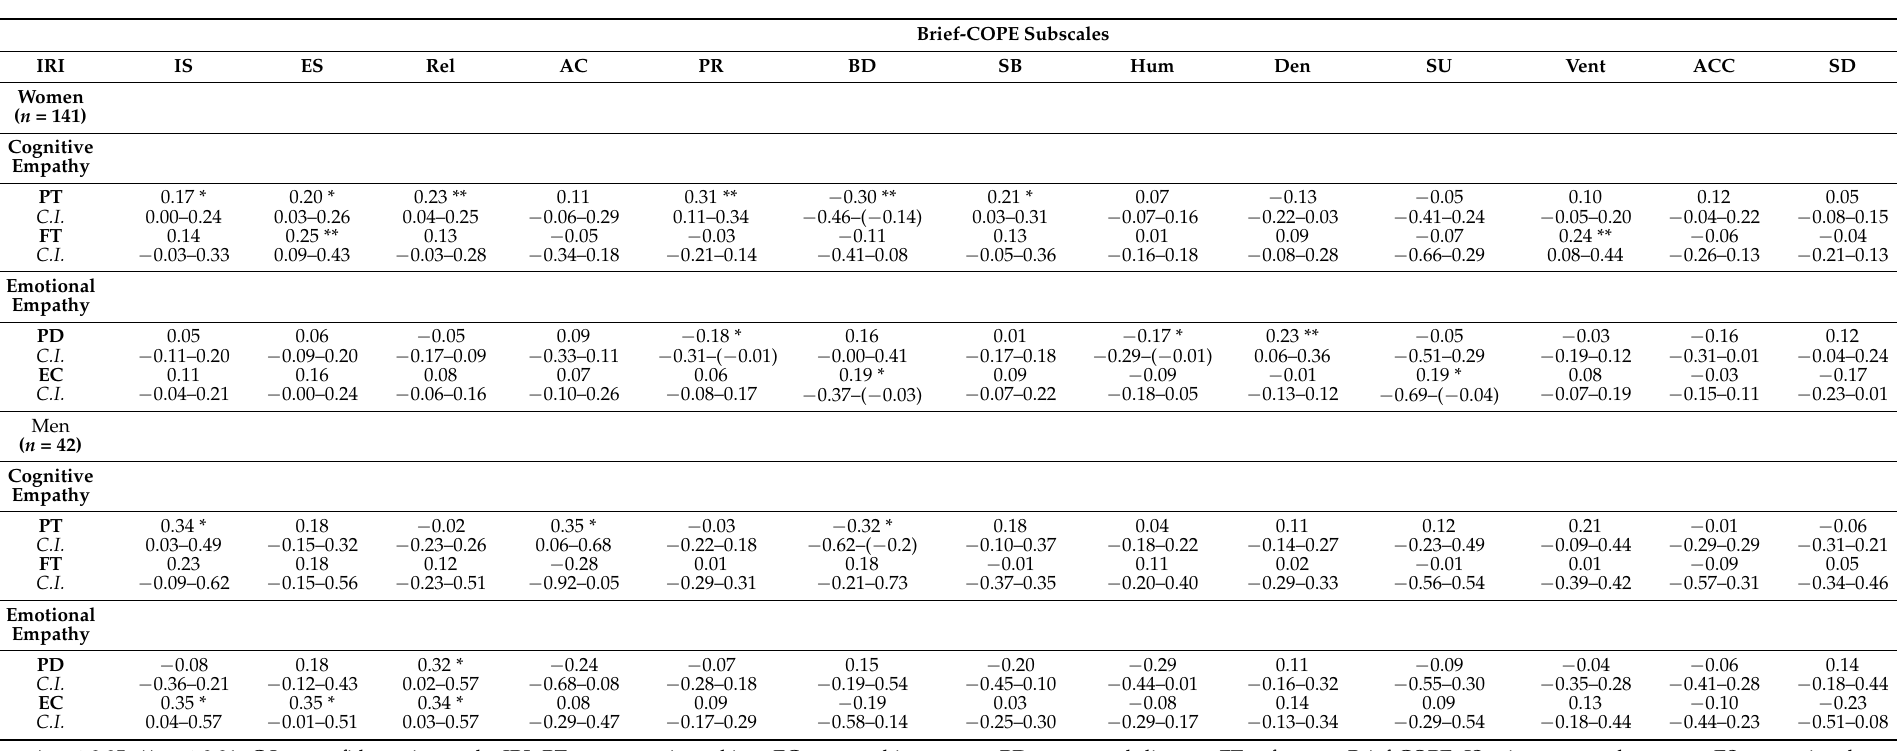
Table 3. Associations between empathy and